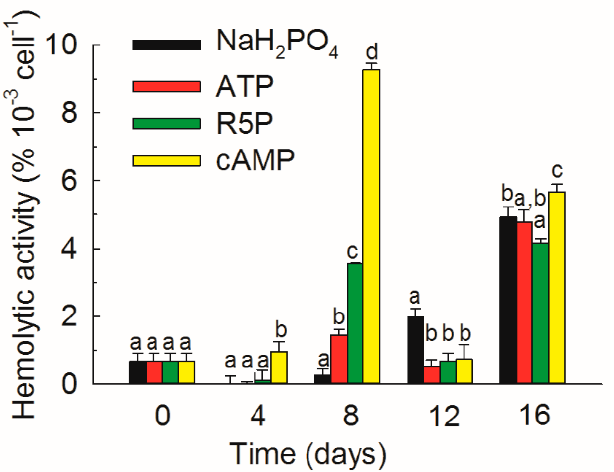
Figure 10. Hemolytic activity of Karenia mikimotoi in the NaH 2 PO 4 , adenosine triphosphate (ATP), ribulose 5-phosphate (R5P), and cyclic adenosine monophosphate (cAMP) treatments on days 0, 4, 8, 12 and 16. The values are the mean ± S.D. ( n = 3). Significant differences ( p < 0.05) among different phosphorus substrates are shown with different lowercase letters.